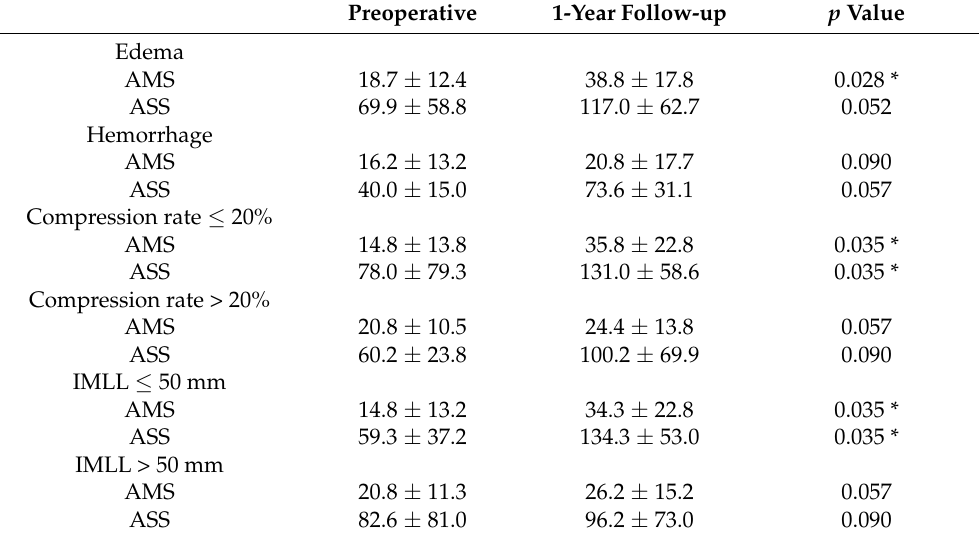
Table 5. Preoperative and 1-year follow-up AIS scores according to MRI type, compression rate, and